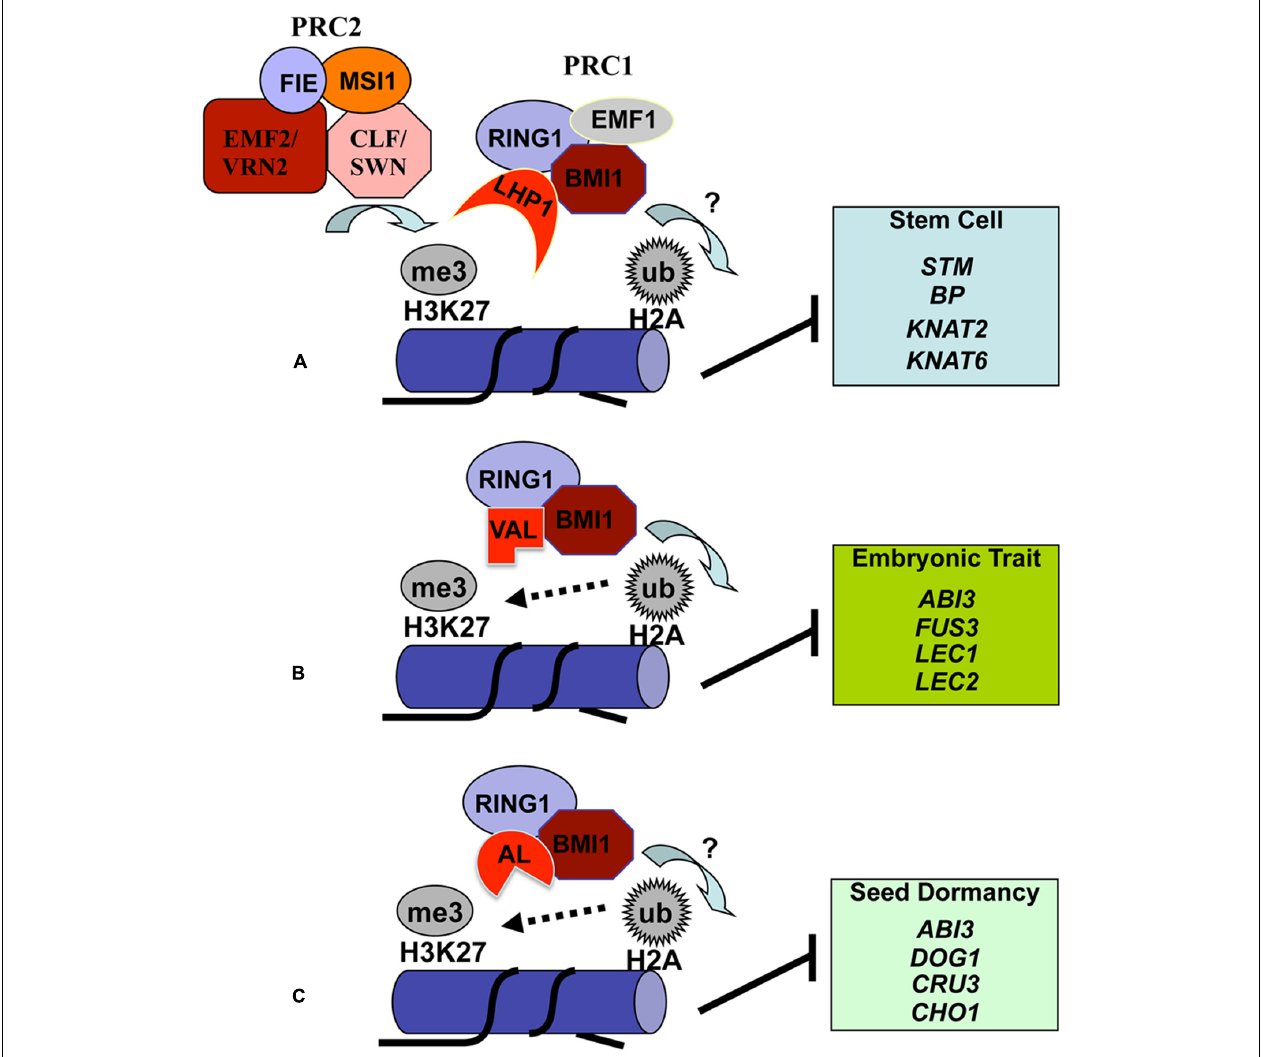
suppression of numerous genes, including the key stem cell regulatory KNOX genes that need to be stably repressed during lateral organ development.The transcription factorVAL is involved in recruitment of BMI1 and RING1 in suppression of embryonic trait genes in somatic cells (B) . AL proteins bind BMI1 and RING1 and play important roles in suppression of several key seed dormancy regulatory genes to promote germination (C) . H3K27me3 deposition at embryonic/seed genes is enhanced byVAL/AL-PRC1 (B,C) , unraveling a non-canonical crosstalk between H3K27me3 and H2Aub1.The question marks indicate that H2Aub1 deposition in the specified target gene chromatin still requires future